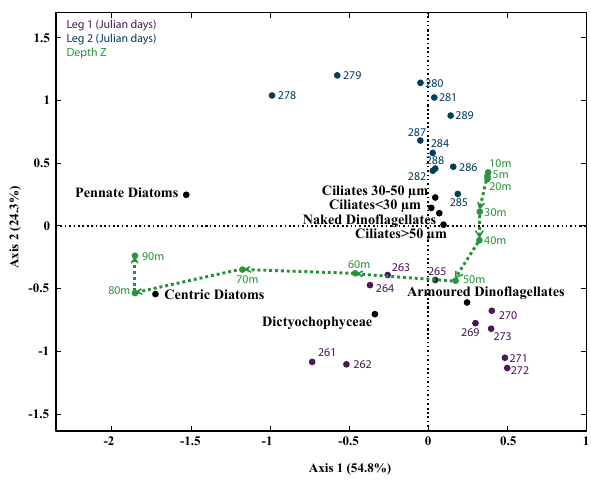
Fig. 6. Spatial and temporal dynamics of the microplankton from hydrological bottle sampling during DYNAPROC 2 cruise. The Correspondence Analysis was applied on the main microplanktonic groups. Sampling depths and Julian days were added as illustrative variables (the coordinates were calculated as the average of samples of the same days or of the same